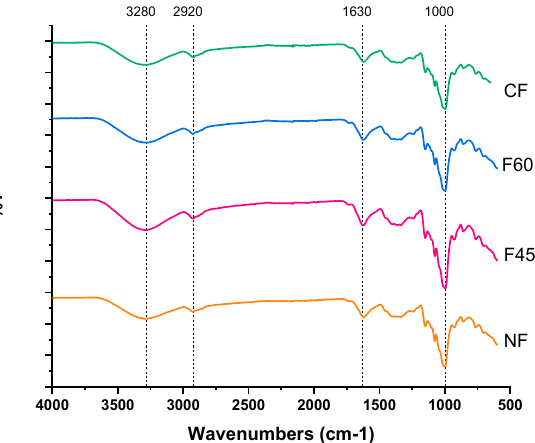
Figure 4. FTIR spectra of Maya nut flour. under different drying treatments. NF-naturally dried flour; F45-flour dried at 45 °C; F60-flour dried at 60 °C; CF-commercial flour. Water absorbed by starch is observed at 1620 cm − 1 . The bands at 1400 cm − 1 and 1300 cm − 1 correspond to C–H bonds. Starch’s fingerprint peaks are at 1150 cm − 1 and 1056 cm − 1 ; peaks at 1019 cm − 1 are attributed to the vibrations of the C–O–C glucose bonds, and bands at 928 cm − 1 , 927 cm − 1 , 856 cm − 1 , 758 cm − 1 , and 678 cm − 1 correspond to the pyranose ring